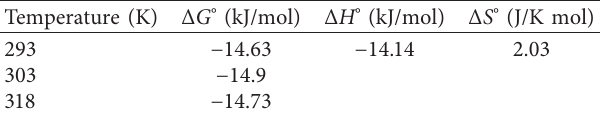
Figure 11: Linear modeling of the MO adsorption isotherm onto sugar scum powder (adsorbent dose � 16g/L; pH � 7.21; T � 22 ° C): (a) Langmuir; (b) Table 3: Thermodynamic parameters for MB adsorption on op- timal activated carbon ( C 0 � 100 mg/L; adsorbent dose � 16g/L; pH � 7.21).